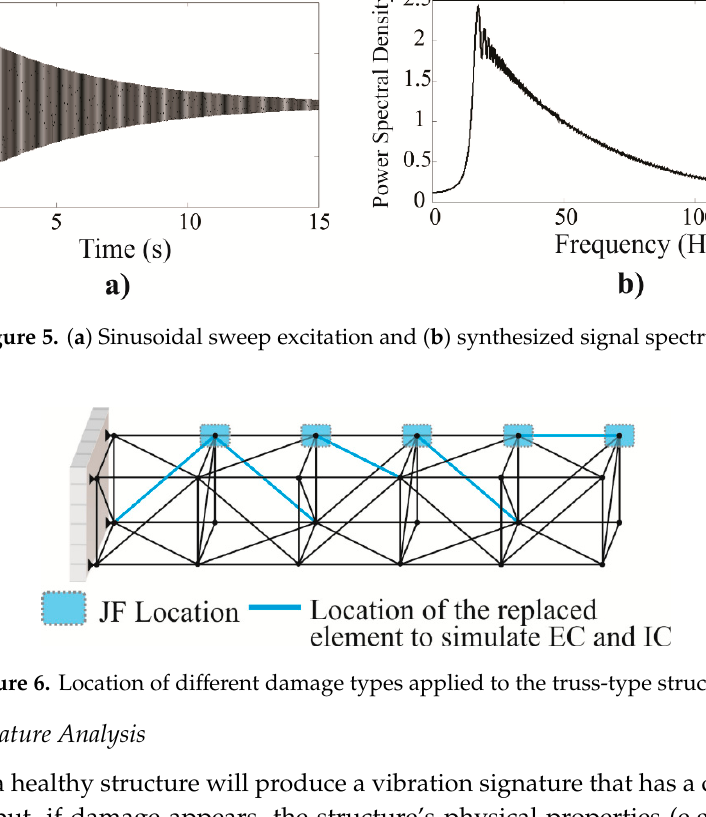
Figure 4. Experimental setup.